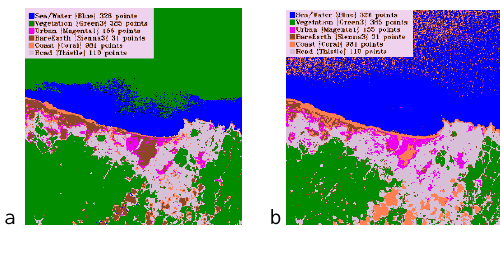
Figure 5: Landsat 5 TM (05/08/1986) a) minimum